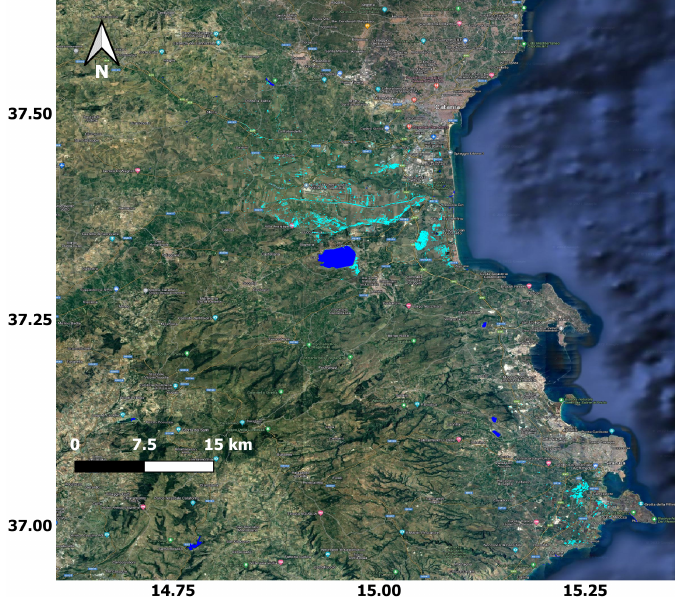
Figure 11. Map of flooded areas generated by AUTOWADE using the CSG image acquired on 30 October 2021 at 04:30